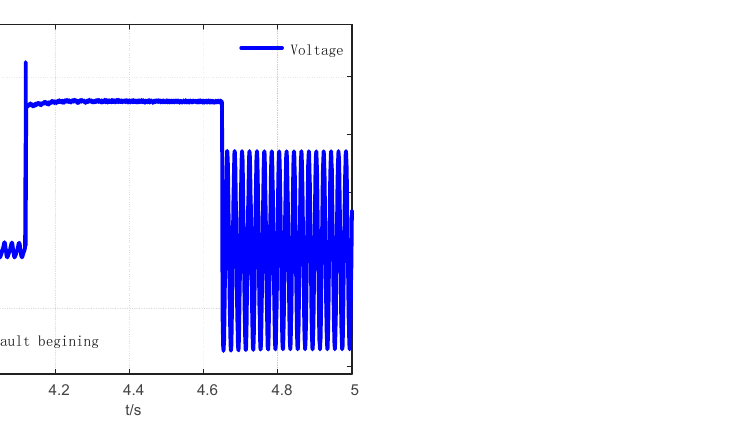
18 of 21 Figure 17. Power angle and speed of the generator. 3.5